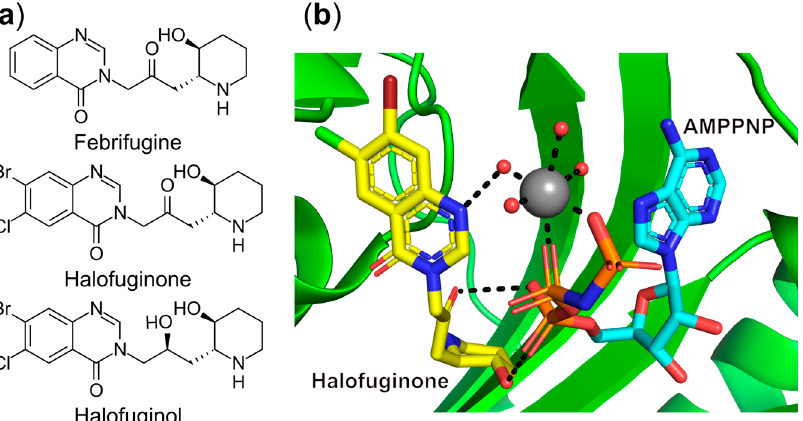
Figure 5. Structures of inhibitors targeting the active site of ProRS. ( a ) Chemical structures of ProRS inhibitors. ( b ) Ternary structure of P. falciparum ProRS in complex with halofuginone and AMPPNP (PDB entry: 4YDQ). The protein backbone is shown as a cartoon representation (green) while halofuginone (yellow C-atoms), AMPPNP (cyan C-atoms), Mg 2+ ion (grey), and water molecules (red) are shown as sticks and spheres, respectively. H-bond interactions are shown as black dashed lines.